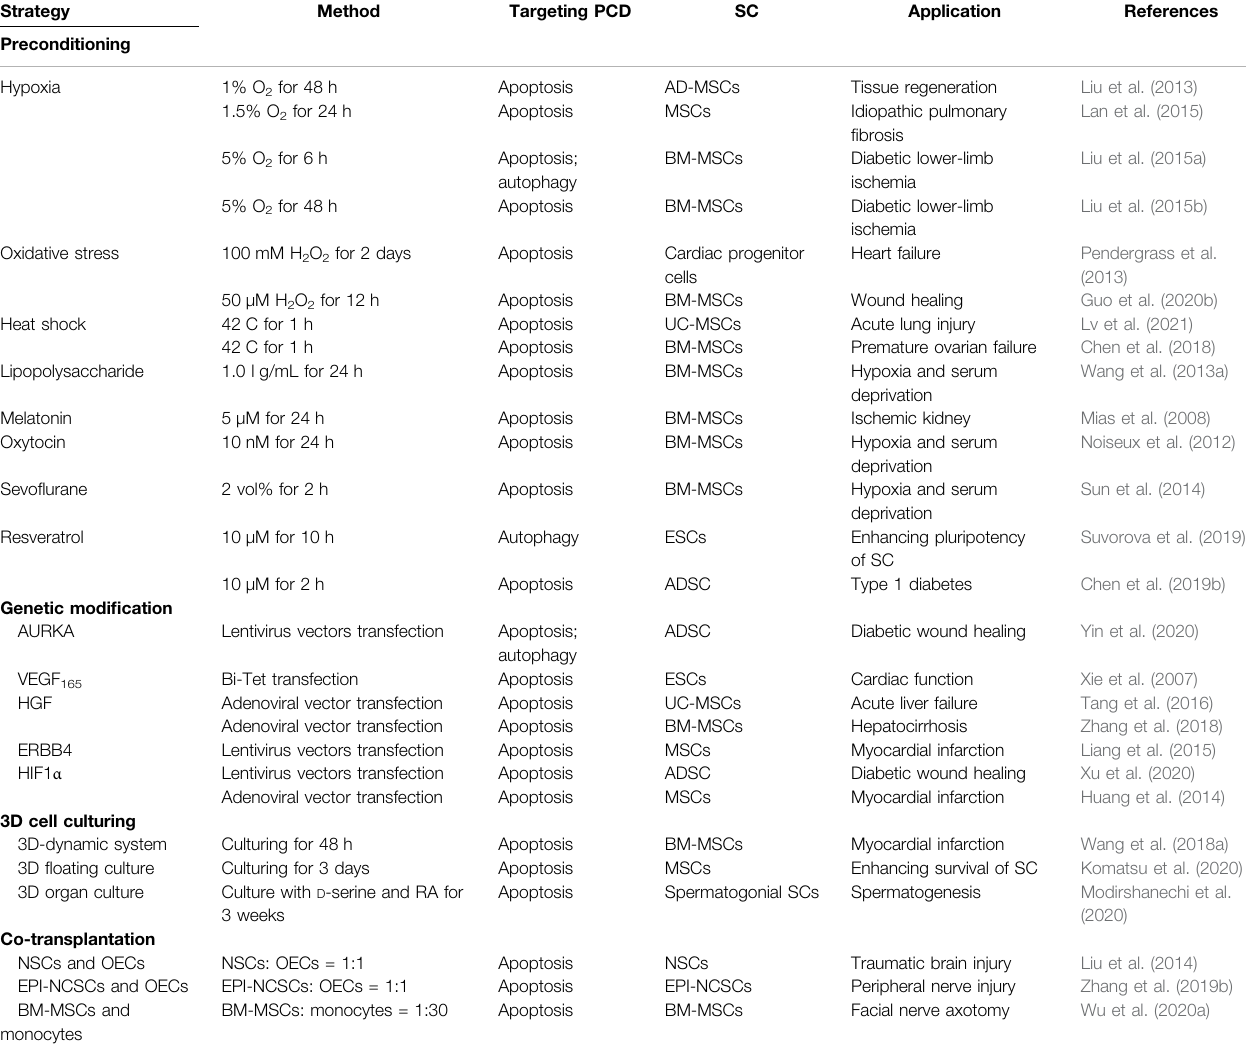
TABLE 1 | Current strategies to prevent PCD of SC for transplantation.